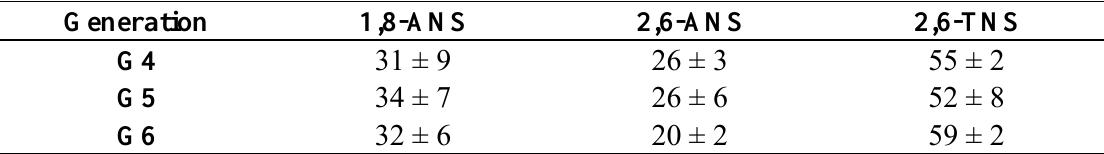
Table 1. The fluorescence enhancements of 4 × 10 -5 M 1,8-ANS, 2,6-ANS and 2,6-TNS by 1 mM PAMAM dendrimers G4 to